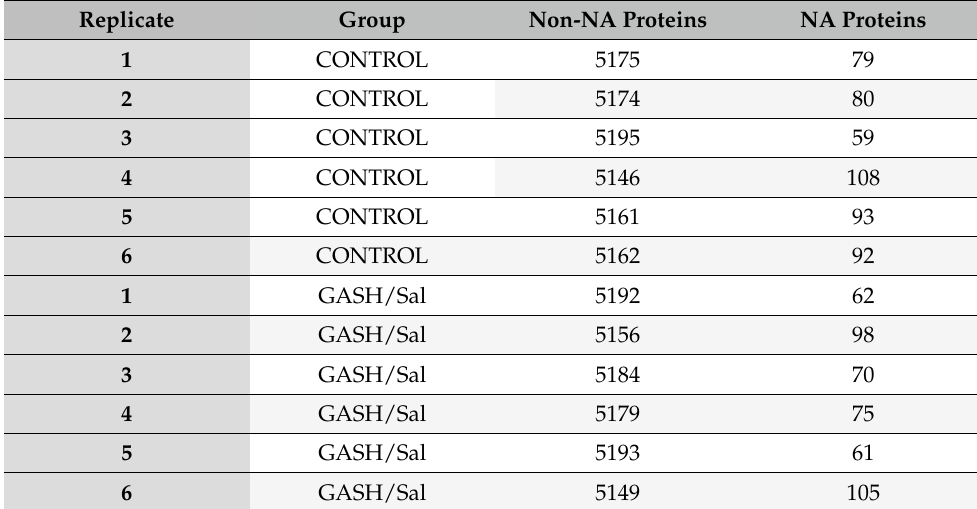
Table 1. Characterization of missing values (NA) in each